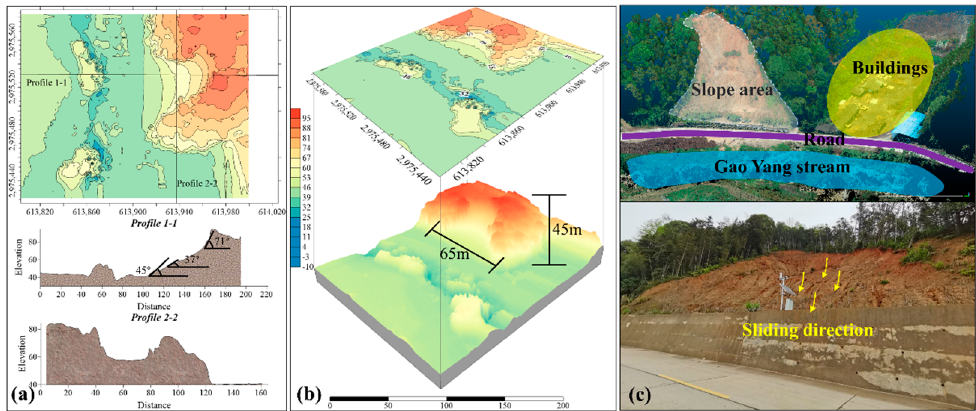
Figure 3. Topography and surrounding layout of the Nanping road slope. ( a ) Two sections of the slope in the north-south and east-west directions; ( b ) Slope size; ( c ) Distribution around the slope.